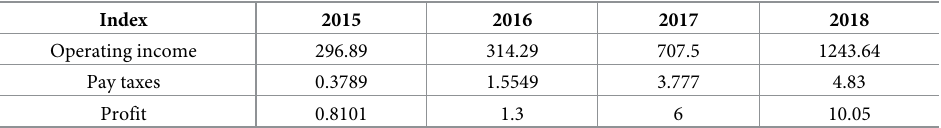
Table 2. Relevant economic indicators of logistics group (unit: 100 million